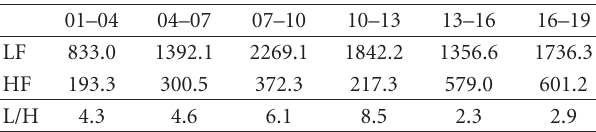
Table 1: HRV measurements of one subject.